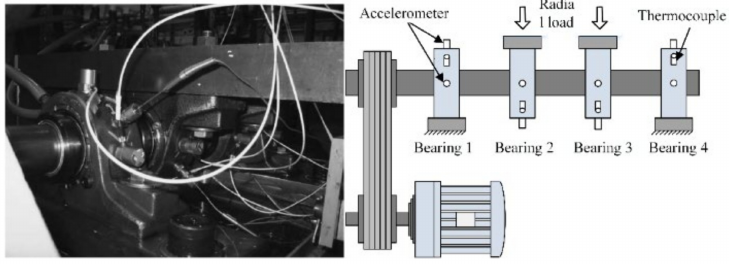
Figure 4. Experimental setup.